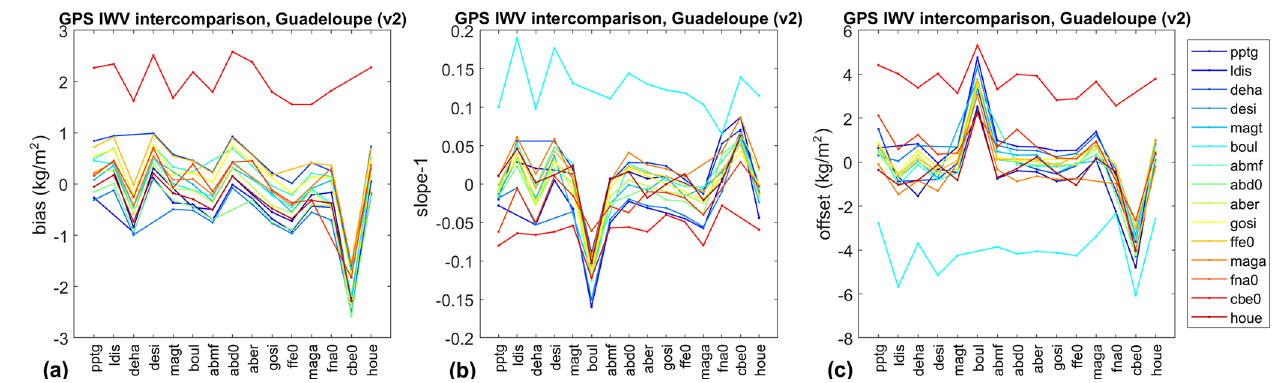
Figure 9. (a) Bias, (b) slope − 1, and (c) offset estimated from all (210) pairs of GPS stations after correction with model v2 for the period from 1 January to 29 February 2020. The station names along the x axis refer to comparisons when the stations are in x , while the colour code indicates comparisons when the stations are in y . The bias is always reported as (cid:49) = µ y − µ x and the linear regression as y = α · x + β . For example, station CBE0 has a positive bias (red curve) when considered in y , while it has a negative bias when considered in x . The comparison results from Fig. 8 were transformed using (cid:49) (cid:48) = µ x − µ y , and α (cid:48) and β (cid:48) according to Eqs. (B4a) and (B4b), when